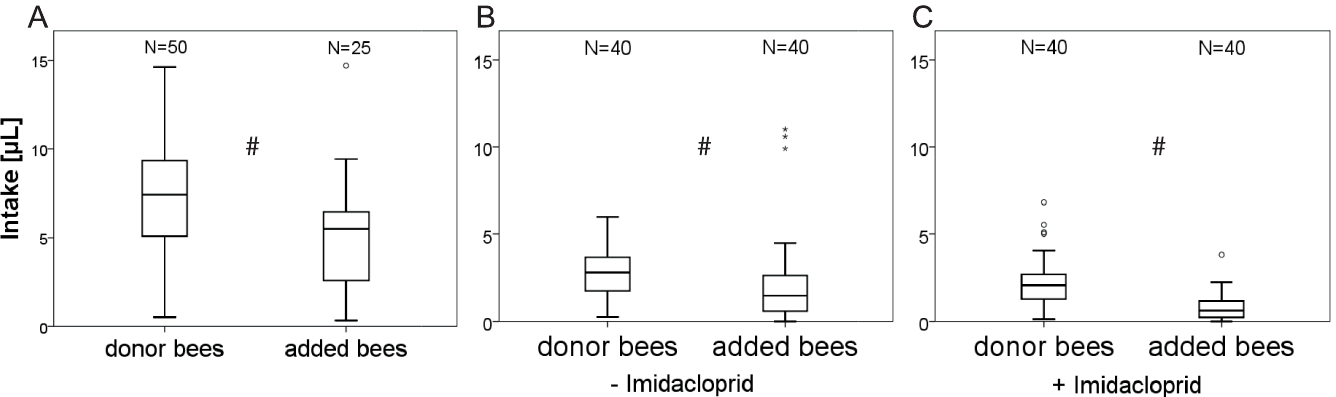
Fig 4. Sugar solution intake of caged bees (donor bees) fed with 14 C-labelled sugar solution and bees added to cages after initial feeding phase (added bees) with and without imidacloprid. A : Intake of donor bees feedingon 100 μ Ltemporary 14 C-labelled sugar solution and subsequent added bees at a ratio of 10:5 (pooleddata from 5 replicates). B : Intake of donor bees feedingon 100 μ Ltemporary 14 C-labelled sugar solutionand subsequent added bees at a ratio of 20:20 (pooleddata from 2 replicates). C : Intake of donor bees feedingon 100 μ Lacute 14 C-labelled sugar solution(LD 50 , 90ng/ 100 μ L)and subsequent addedbees at a ratio of 20:20 (pooleddata from 2 replicates). # indicatesdifferencesat p < 0.05, Mann-Whitney U-test. ˚ indicates outliers (valuesbetween1.5 and 3 times the interquartile range) and * indicates far outliers (more than 3 times the interquartile range).